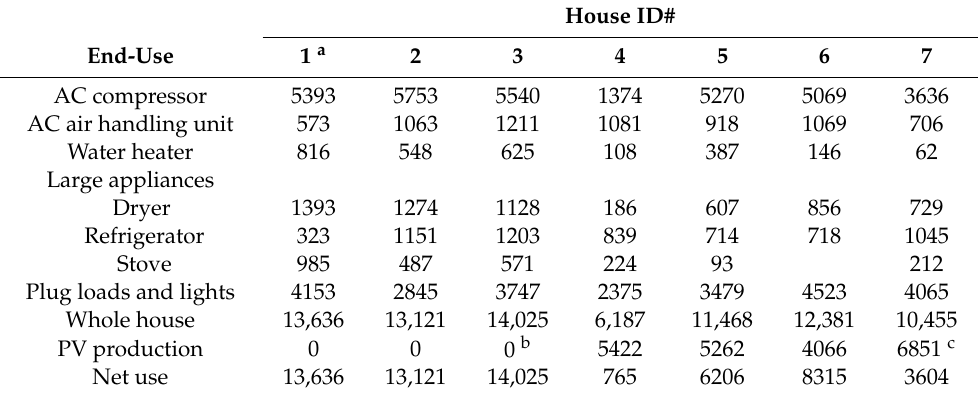
Table 4. Annual energy use (kWh / year) disaggregated by end use and PV production for the seven metered houses.